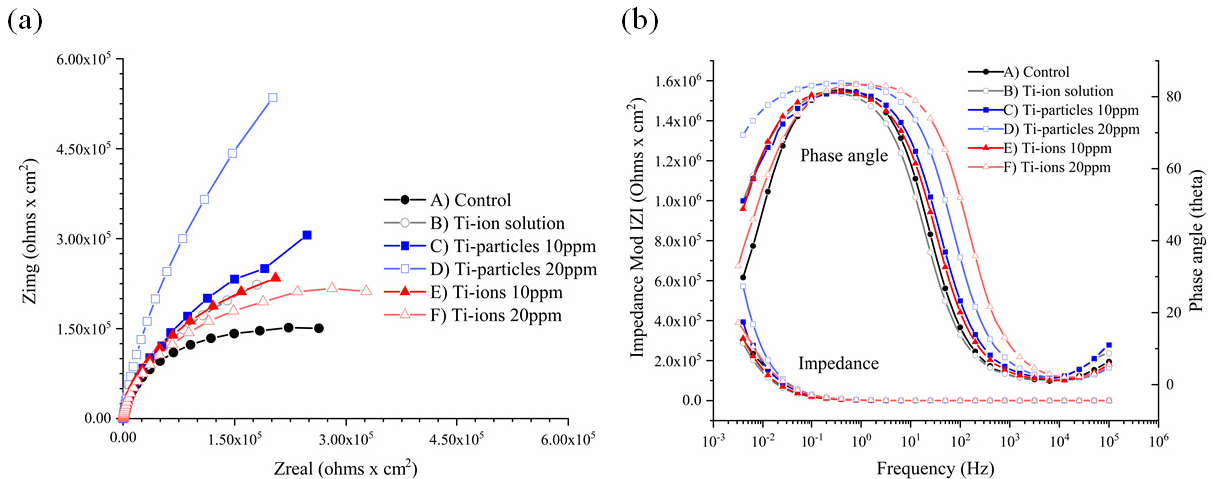
Figure 4. Representative ( a ) Nyquist plots and ( b ) Bode plots obtained from EIS tests with different electrolytes.